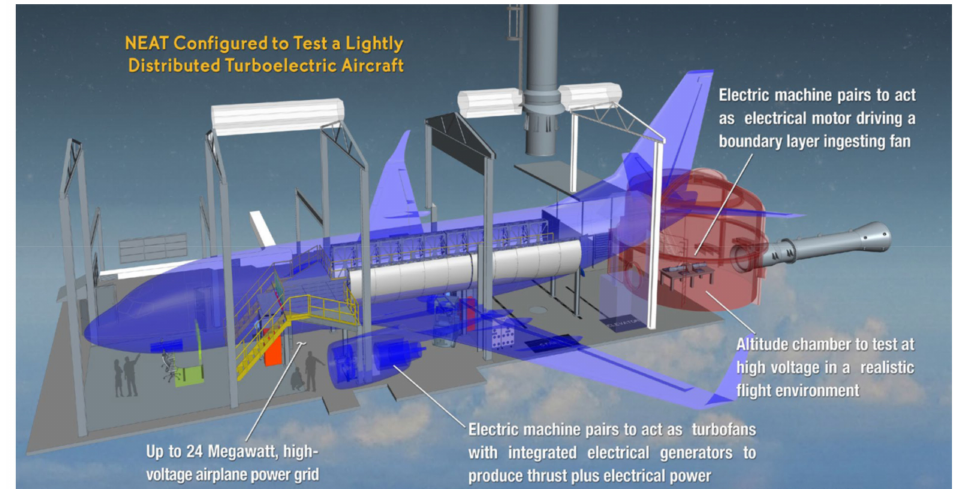
Figure 5. NASA electric aircraft testbed. Source: NASA / MIT / Aurora Flight